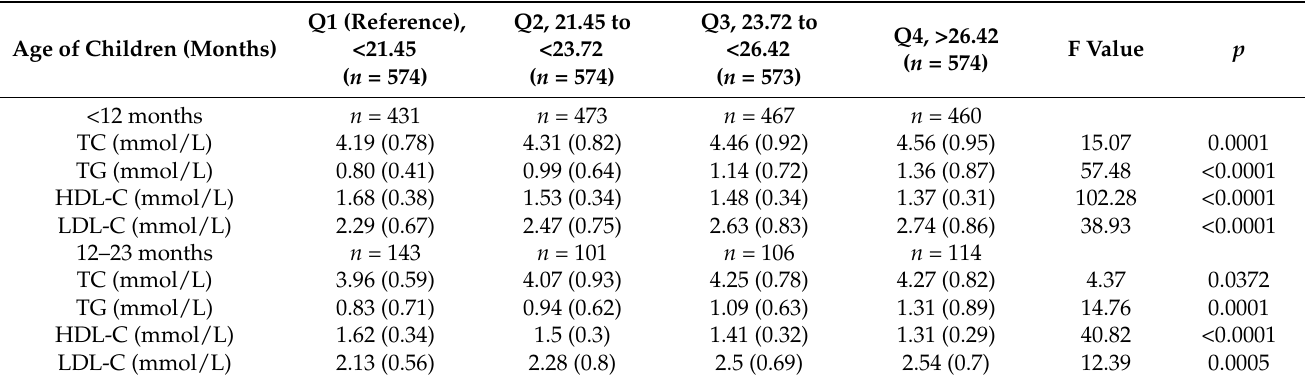
Table 2. BMI values according to age of children (months) and BMI quartile in lactating women (mean values and standard